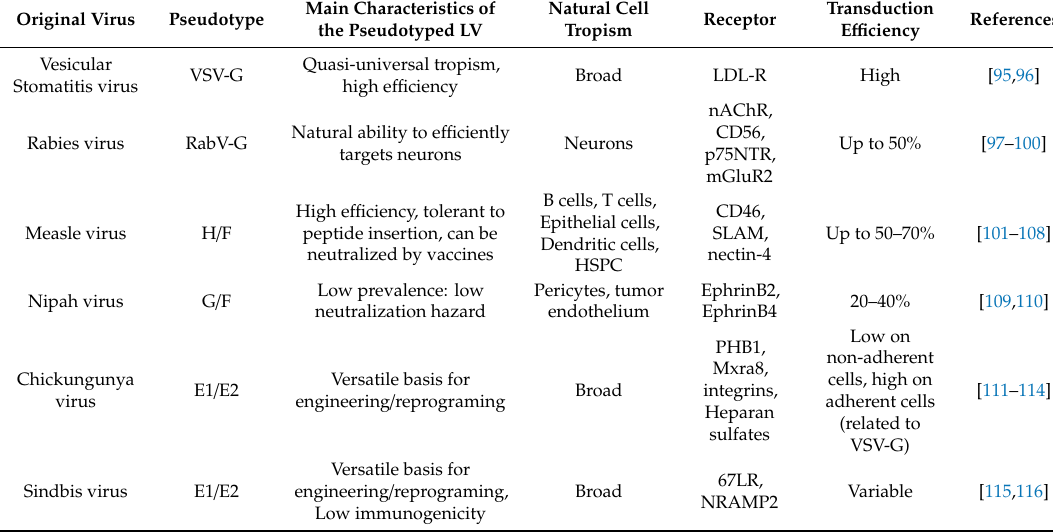
Figure 4. Outline of the mechanisms of viral entry by the main envelope proteins that can be used to pseudotype LV vectors. ECM: Extracellular Medium; MVB: Multivesicular Body. Table 1. Overview table summarizing the main characteristics of the pseudotypes discussed in this